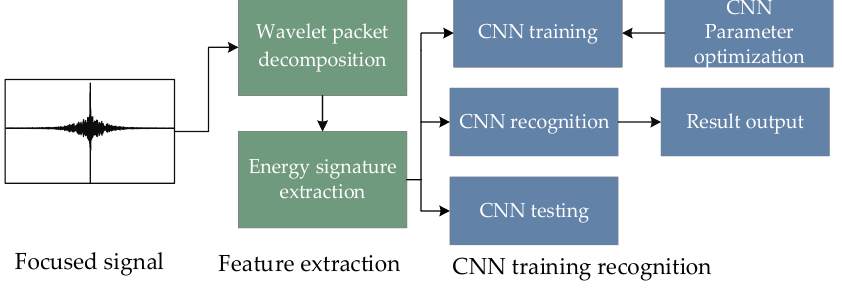
Figure 2. Structure of WPE-CNN.